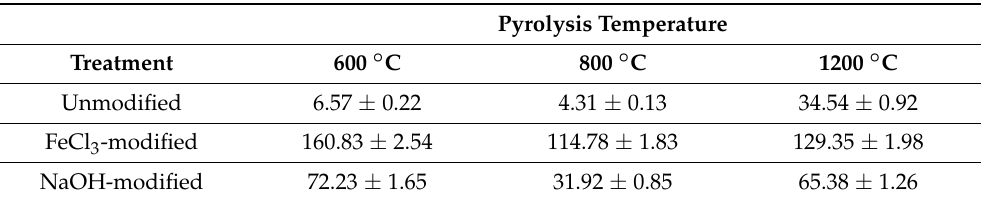
Table 2. Specific surface area (m 2 /g) of biochars at each pyrolysis temperature and after chemical